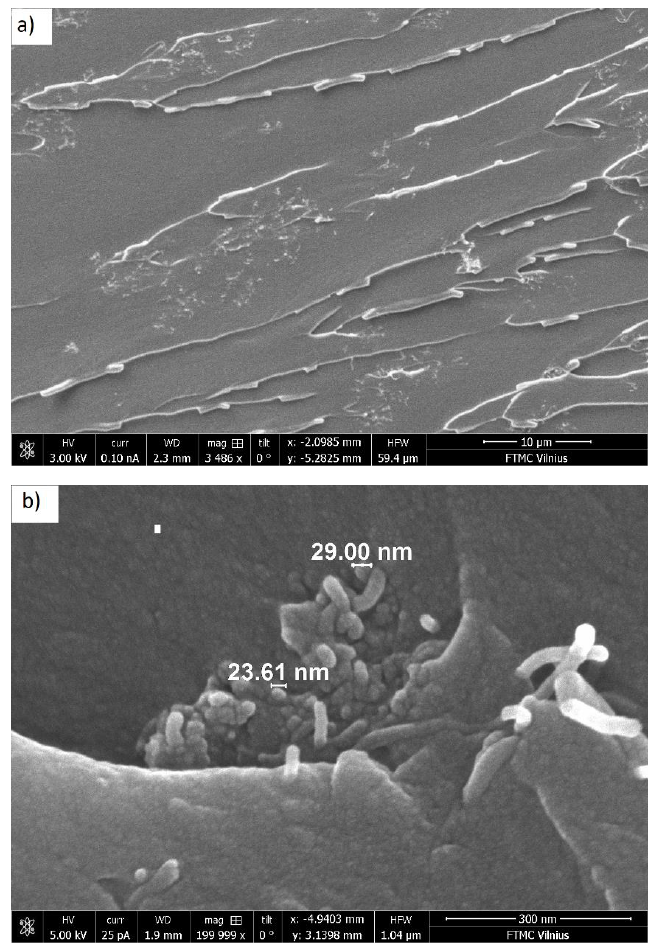
Figure 2. SEM micrographs of the epoxy resin composite with 0.09 vol.% of MWCNTs and 0.025 MnFe 2 O 4 content at ( a ) low and ( b ) high